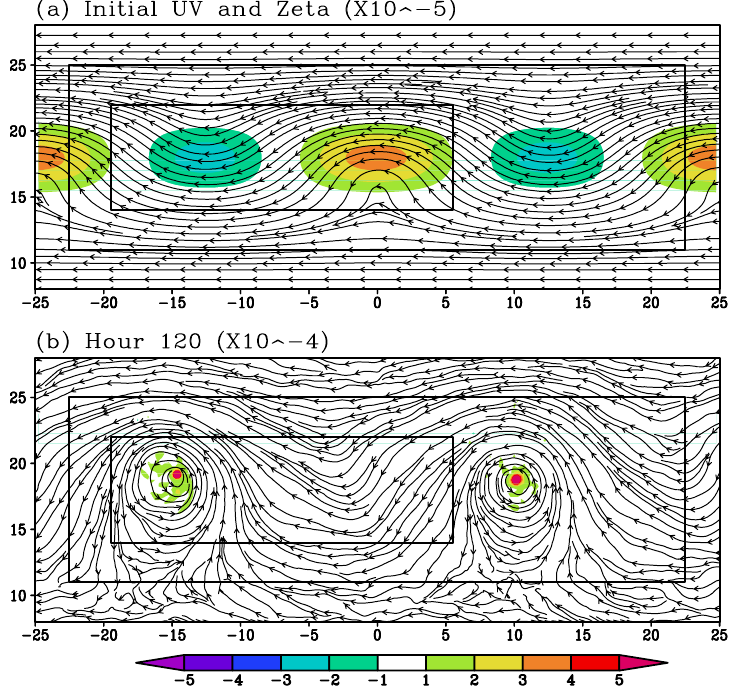
Fig. 11. The 3-grid nested simulation: Relative vorticity and the corresponding (Earth-relative) streamlines at the initial time (a) and after 120h integration (b) . The two rectangles represent the two inner grids. The ordinate is latitude and the abscissa is longitude.